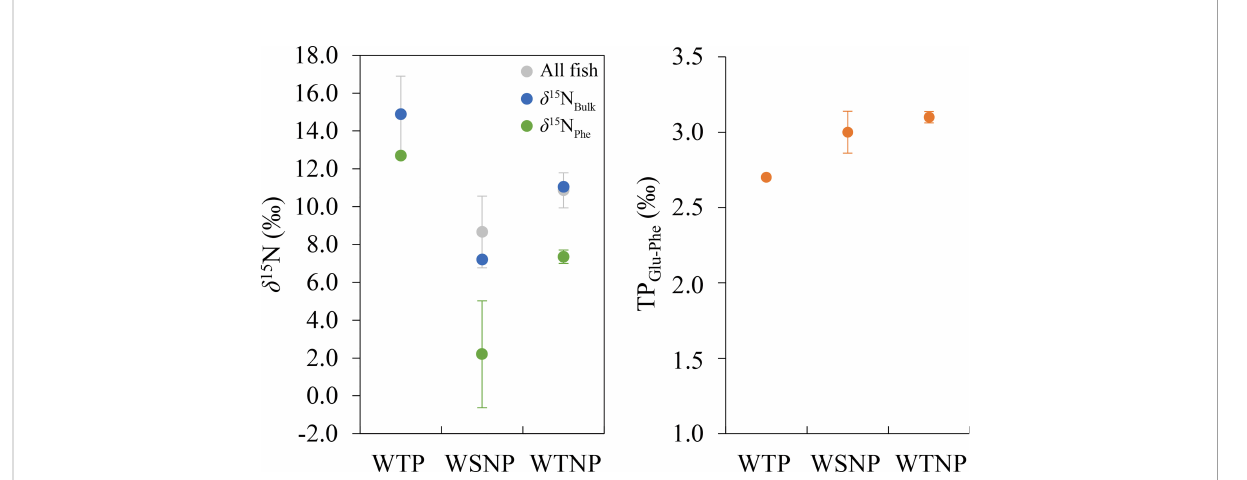
FIGURE 5 Mean d 15 N Bulk and d 15 N Phe (left), and TP Glu – Phe (right) of skipjack tuna ( Katsuwonus pelamis ) in the western tropical Paci fi c (WTP), western subtropical North Paci fi c (WSNP), and western temperate North Paci fi c (WTNP). Gray, blue and green datapoints in the left panel indicate the mean (±SD) d 15 N Bulk of all skipjack samples, d 15 N Bulk and d 15 N Phe of skipjack used for d 15 N AAs , respectively. Orange datapoints in the right panel are the TP Glu – Phe of skipjack used for determining d 15 N AAs